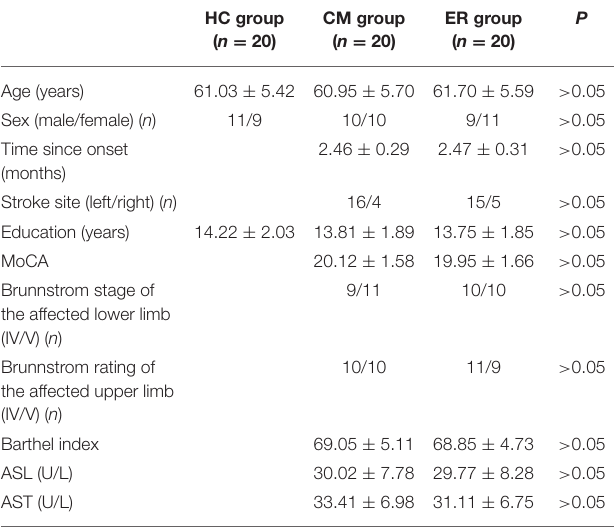
TABLE 1 | Comparison of the basic demographic information for each